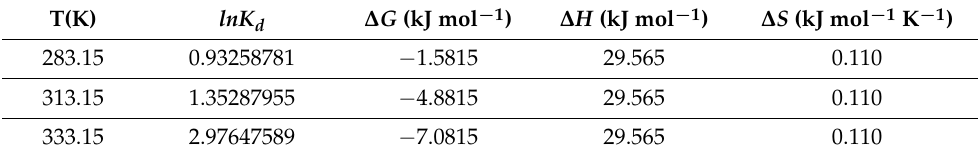
Figure 7. Effect of temperature on the distribution of the adsorption coefficient of the D-Mn (triangles) and D-Cr gels (circles). Table 6. Thermodynamic parameters of As adsorption in the D-Mn gel.